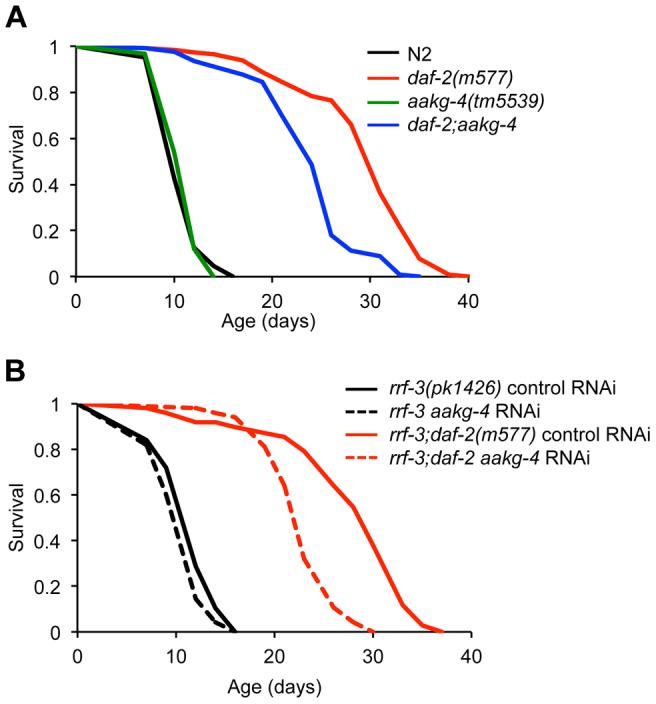

aakg-4 mutation or aakg-4(RNAi) shorten the lifespan of daf-2(m577) animals.
A and B) One representative experiment is shown in each case, corresponding to A) Trial 1 in Table S7 and B) Trial 5 in Table S8. Lifespan measurements carried out at 25°C.